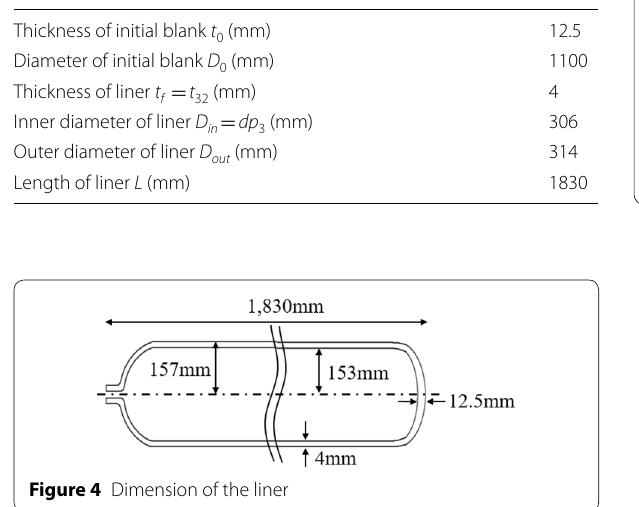
Table 1 Dimension of the initial blank and the liner Parameter